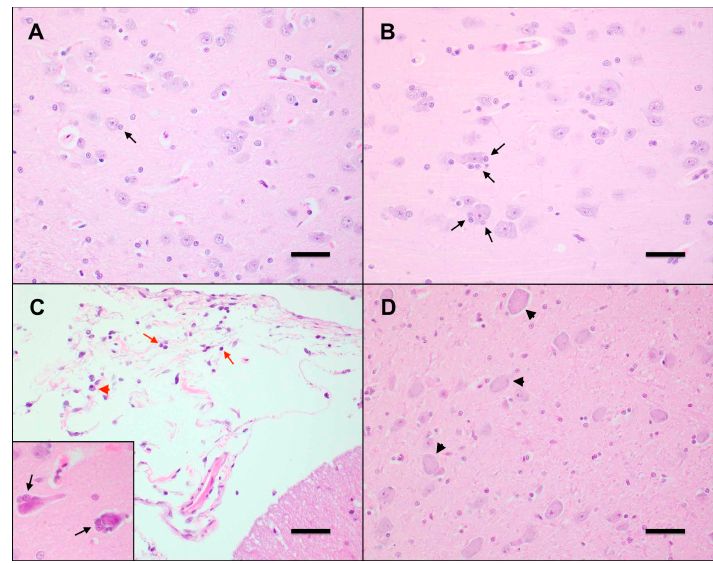
Figure 5. FFV-infected cats exhibit early neurodegenerative changes in the central nervous system. ( A ) Neurons in the CNS of control cat N4 contain uniform, round nuclei, abundant basophilic Nissl substance, and are flanked by few glial cells (black arrow). Frontal lobe, Hematoxylin-eosin (HE) 400×. Scale bar = 100 µm. ( B ) Neurons in the CNS of FFV-infected cat FFV3 exhibit moderate satellitosis, characterized by increased numbers of glial cells (black arrows). Thalamus, HE 400×. Scale bar = 100 µm. ( C ) The meninges of FFV-infected cat FFV5 are expanded by minimal numbers of mature small lymphocytes (red arrows) and plasma cells (red arrowheads). Cerebellum, HE 400×. Scale bar = 100 μ m. Neurons in the frontal lobe of this animal (inset) are shrunken, with hypereosinophilic cytoplasm, and exhibit moderate satellitosis (black arrows). Frontal lobe, HE 400×. ( D ) Neurons in the CNS of an FFV-infected cat are swollen and rounded, with an indistinct nucleus and a dispersed Nissl substance (chromatolysis). Thalamus, HE 400×. Scale bar = 100 µm.